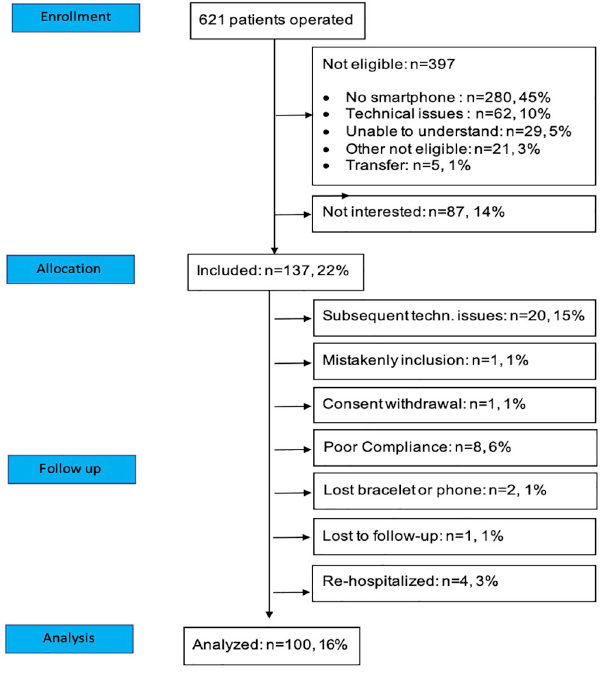
Fig 1. Study consort flow